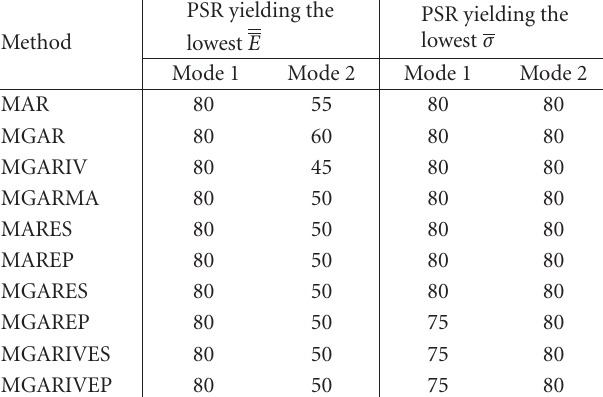
Table 5: PSR values for lowest average mean engine order error and average standard deviation of all noise sequences.